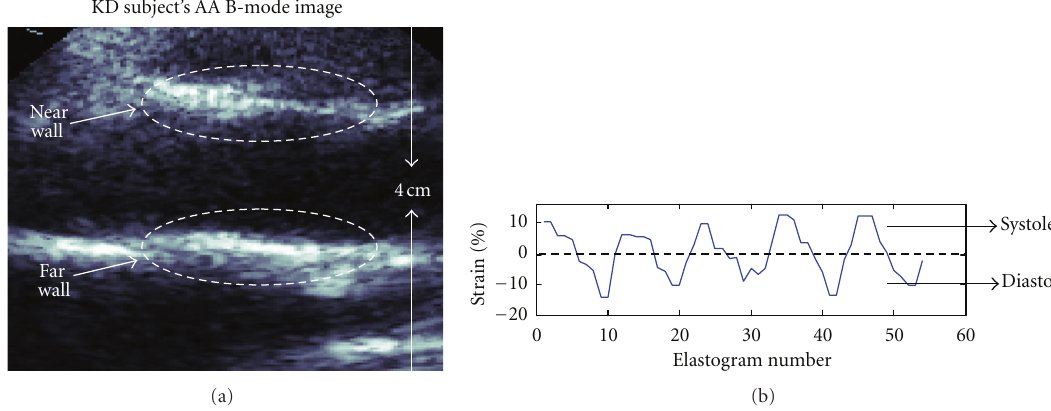
Figure 6: (a) Ascending aorta B-mode image of a KD subject and (b) MAS curve clearly delineating the systolic phase (with positive strain values) and diastolic phase (with negative strain values).